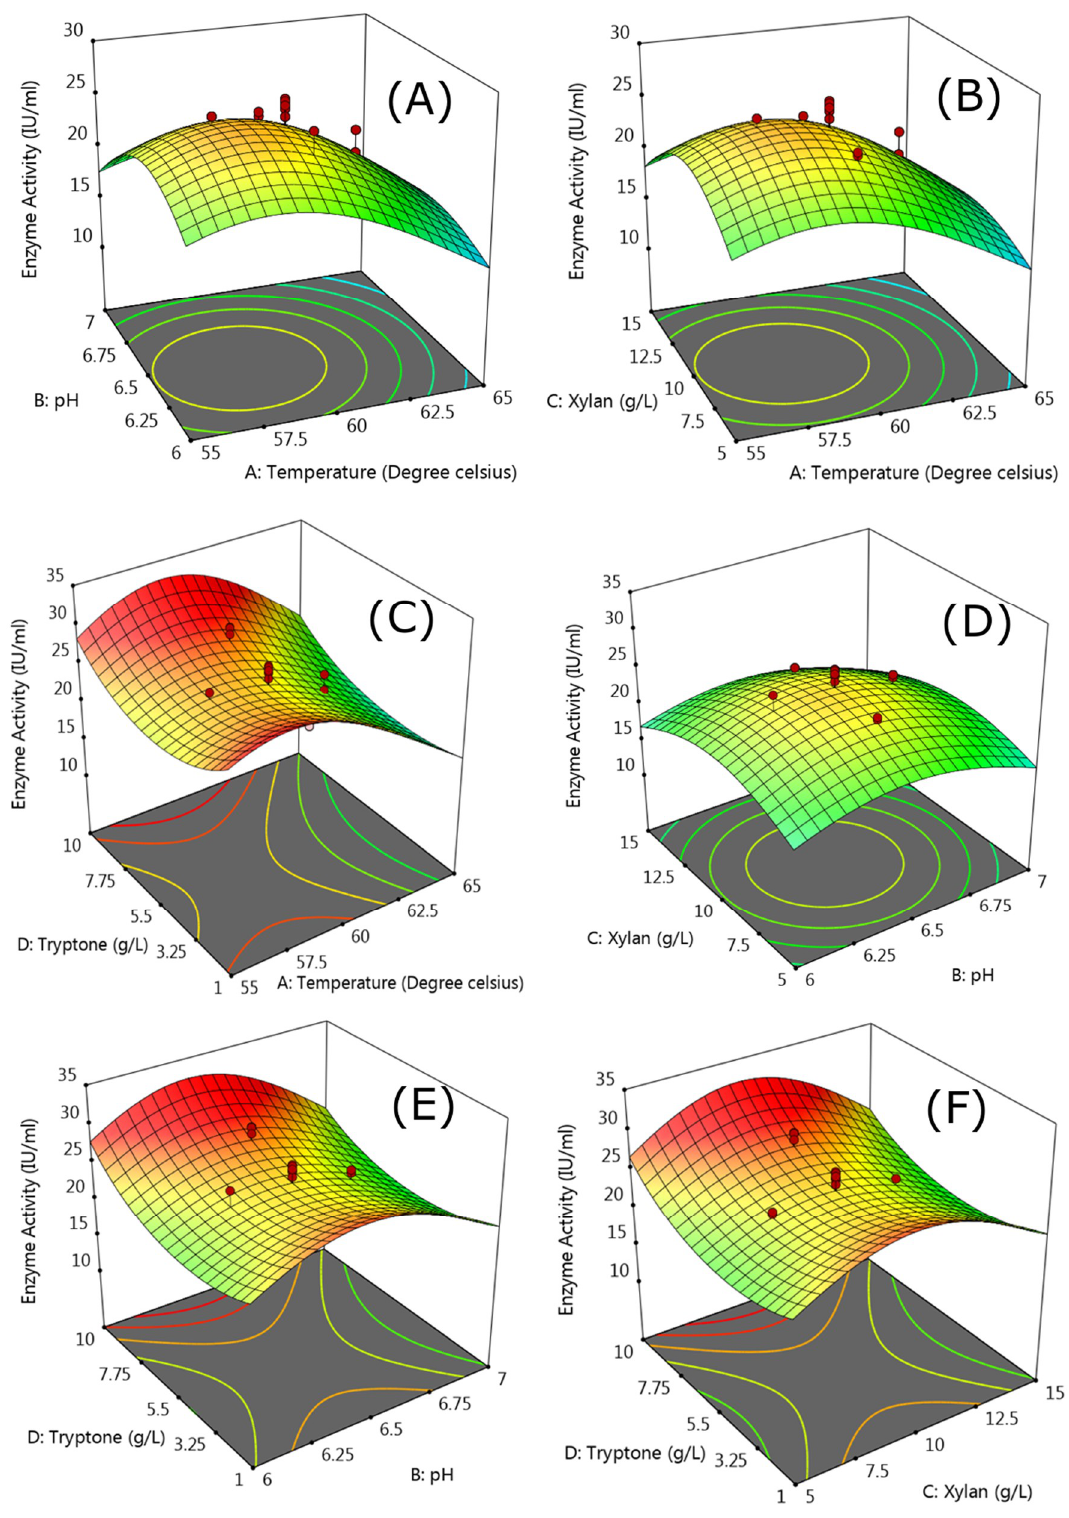
Figure 5. Response surface 3D response plots showing interaction between ( A ) temperature and pH, ( B ) temperature and xylan, ( C ) temperature and tryptone, ( D ) pH and xylan, ( E ) pH and tryptone, and ( F ) xylan and tryptone. The green color represents the minimum value whereas the red color represents the maximum values. The points above or below the response surface area respectively represent the values which are higher or lower than the predicted response value for the enzymatic activity.